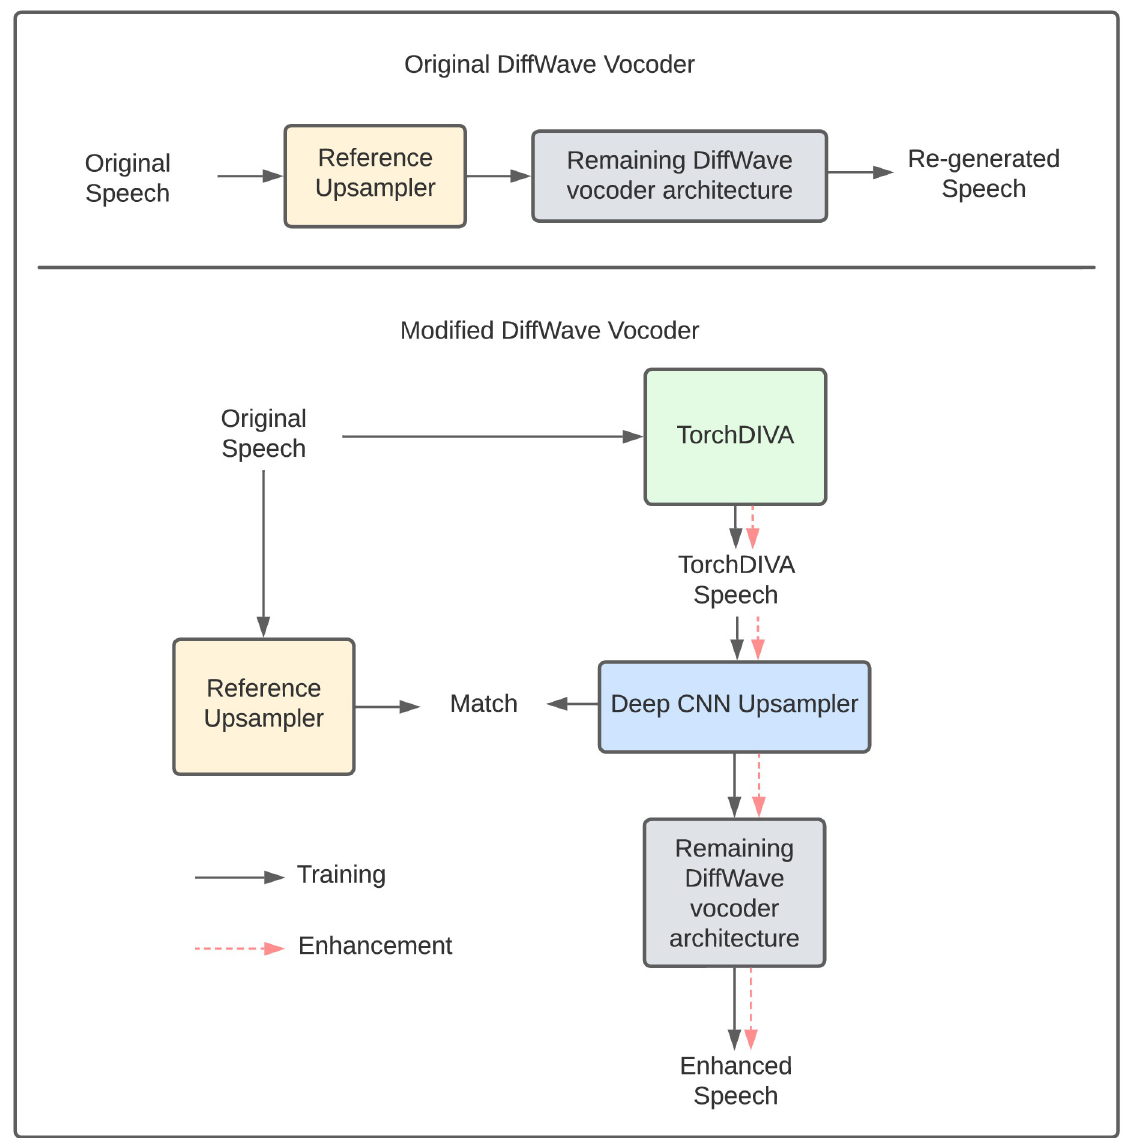
Fig 2. DiffWave supervised training process. Top: Process for training in the original DiffWave model. Bottom: Modified DiffWave training, using a deep CNN upsampler to match the conditioner in DiffWave’s reference upsampler.